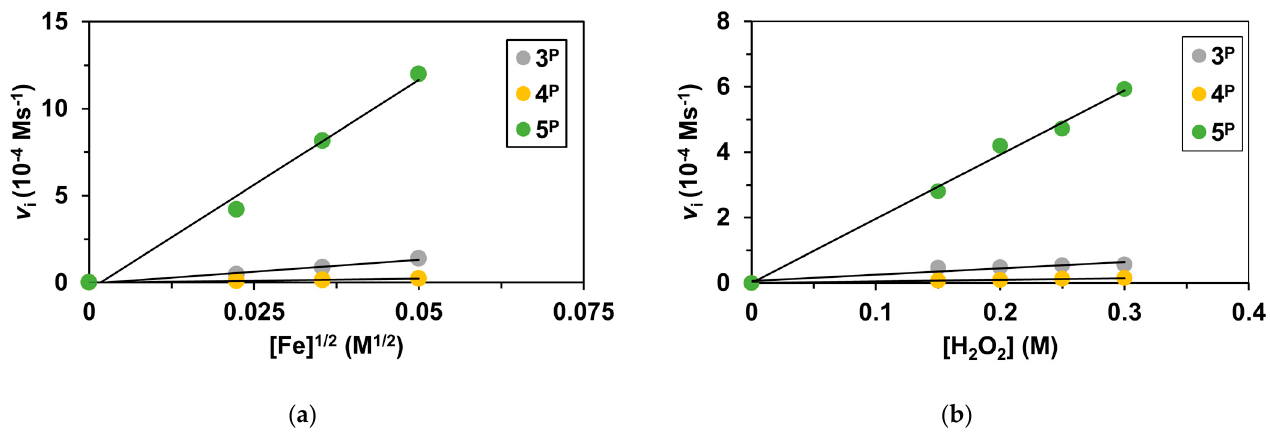
Figure 13. Comparison of the 3 P – 5 P -mediated disproportionation reaction of H 2 O 2 in MeCN at 298 K. ( a ) Dependence of the reaction rate ( V i ) on the in situ generated [ 3 P – 5 P ] concentration: [H 2 O 2 ] 0 = 0.3 M. ( b ) Dependence of the reaction rate ( V i ) on the [H 2 O 2 ] 0 concentration: [ 3 P – 5 P ] = 0.5 mM. Table 3. Kinetic data for the diiron(III)-mediated ( 3 P – 5 P ) disproportionation reaction of H 2 O 2 derived from gas volumetric measurements in MeCN at 298 K.